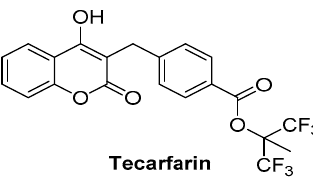
Figure 50. Structure of Tecarfarin.